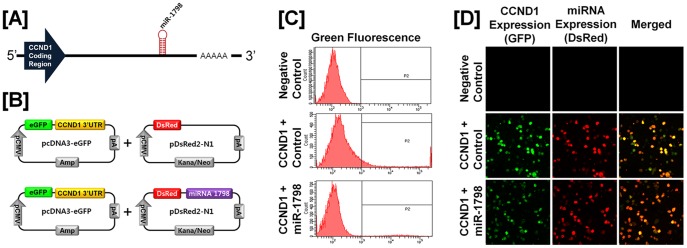

In vitro target assay for microRNAs on the CCND1 transcript.[A] Diagram of miR-1798 binding sites in the 3′-UTR of the CCND1 gene. [B] Expression vector maps for eGFP within the 3′-UTR of the CCND1 gene and Ds-Red within each miRNA. The 3′-UTR of the CCND1 transcript was subcloned between the eGFP gene and the polyA tail to generate the fusion construct of the GFP transcript following the miRNA target 3′-UTR (pcDNA-eGFP-3′UTR) (upper panel) and the miRNA expression vector was designed to co-express DsRed and each miRNA (pcDNA-DsRed-miRNA) (lower panel). [C and D] After co-transfection of pcDNA-eGFP-3′UTR for the CCND1 transcript and pcDNA-DsRed-miRNA for miR-1798, the fluorescence signals of GFP and DsRed were detected using FACS [C] and fluorescent microscopy [D]. See Materials and Methods for complete description.